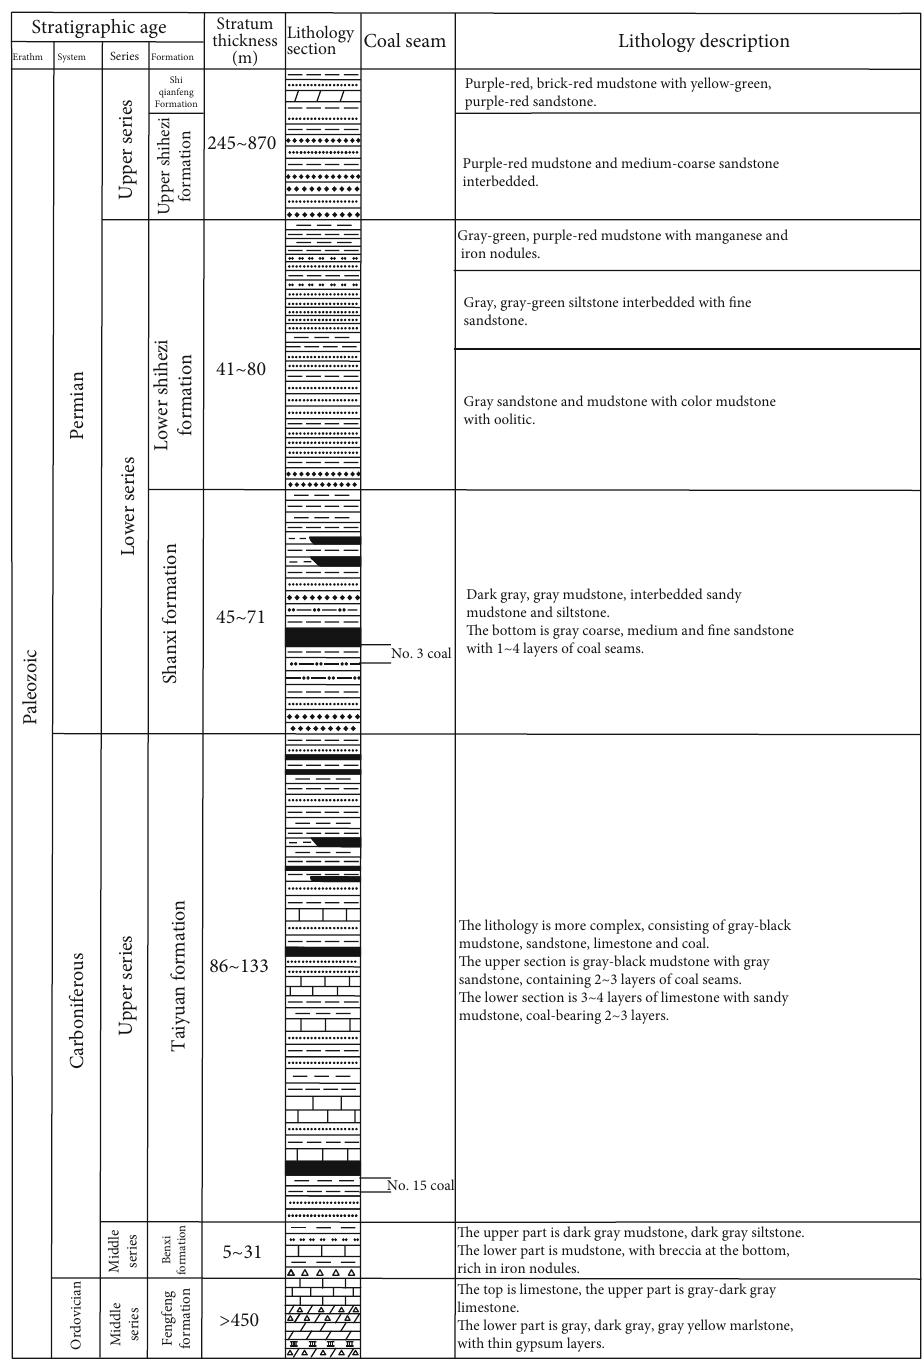
Figure 2: Stratigraphic column of coal-bearing sequences in the Mabidong